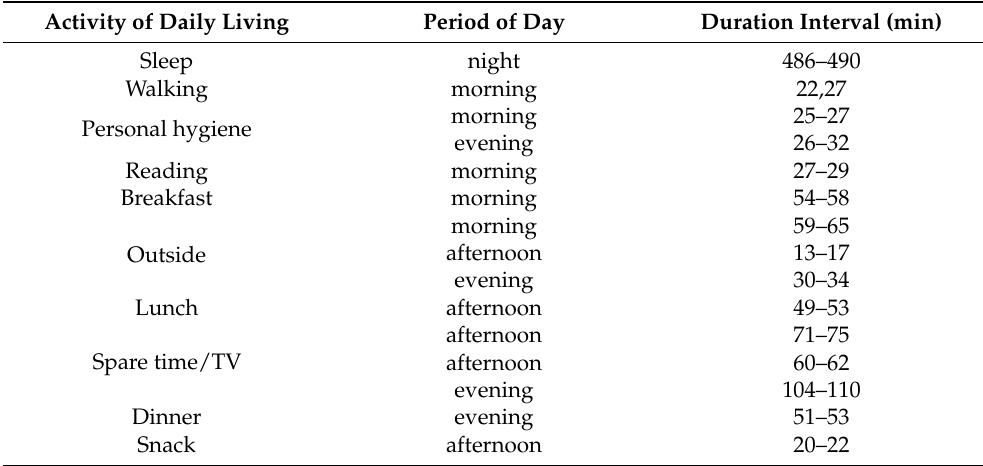
Table 2. Duration intervals for the activities part of the first routine returned by the genetic algorithm for patient with id 6.